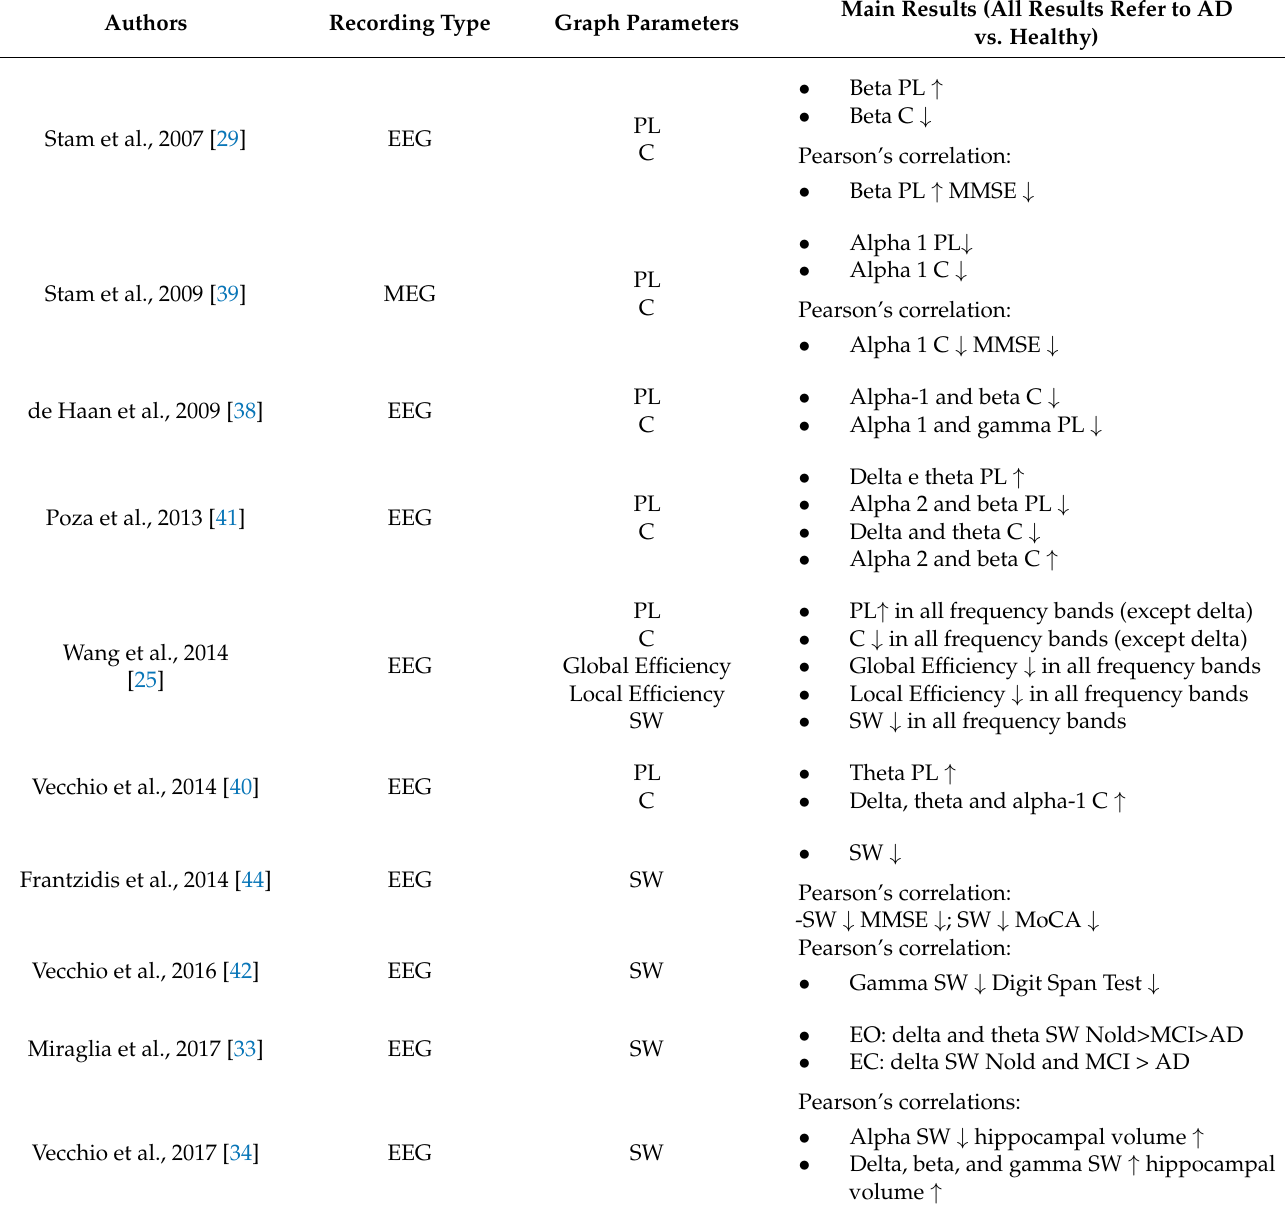
Table 2. Summary of the main results of AD studies reported in the present